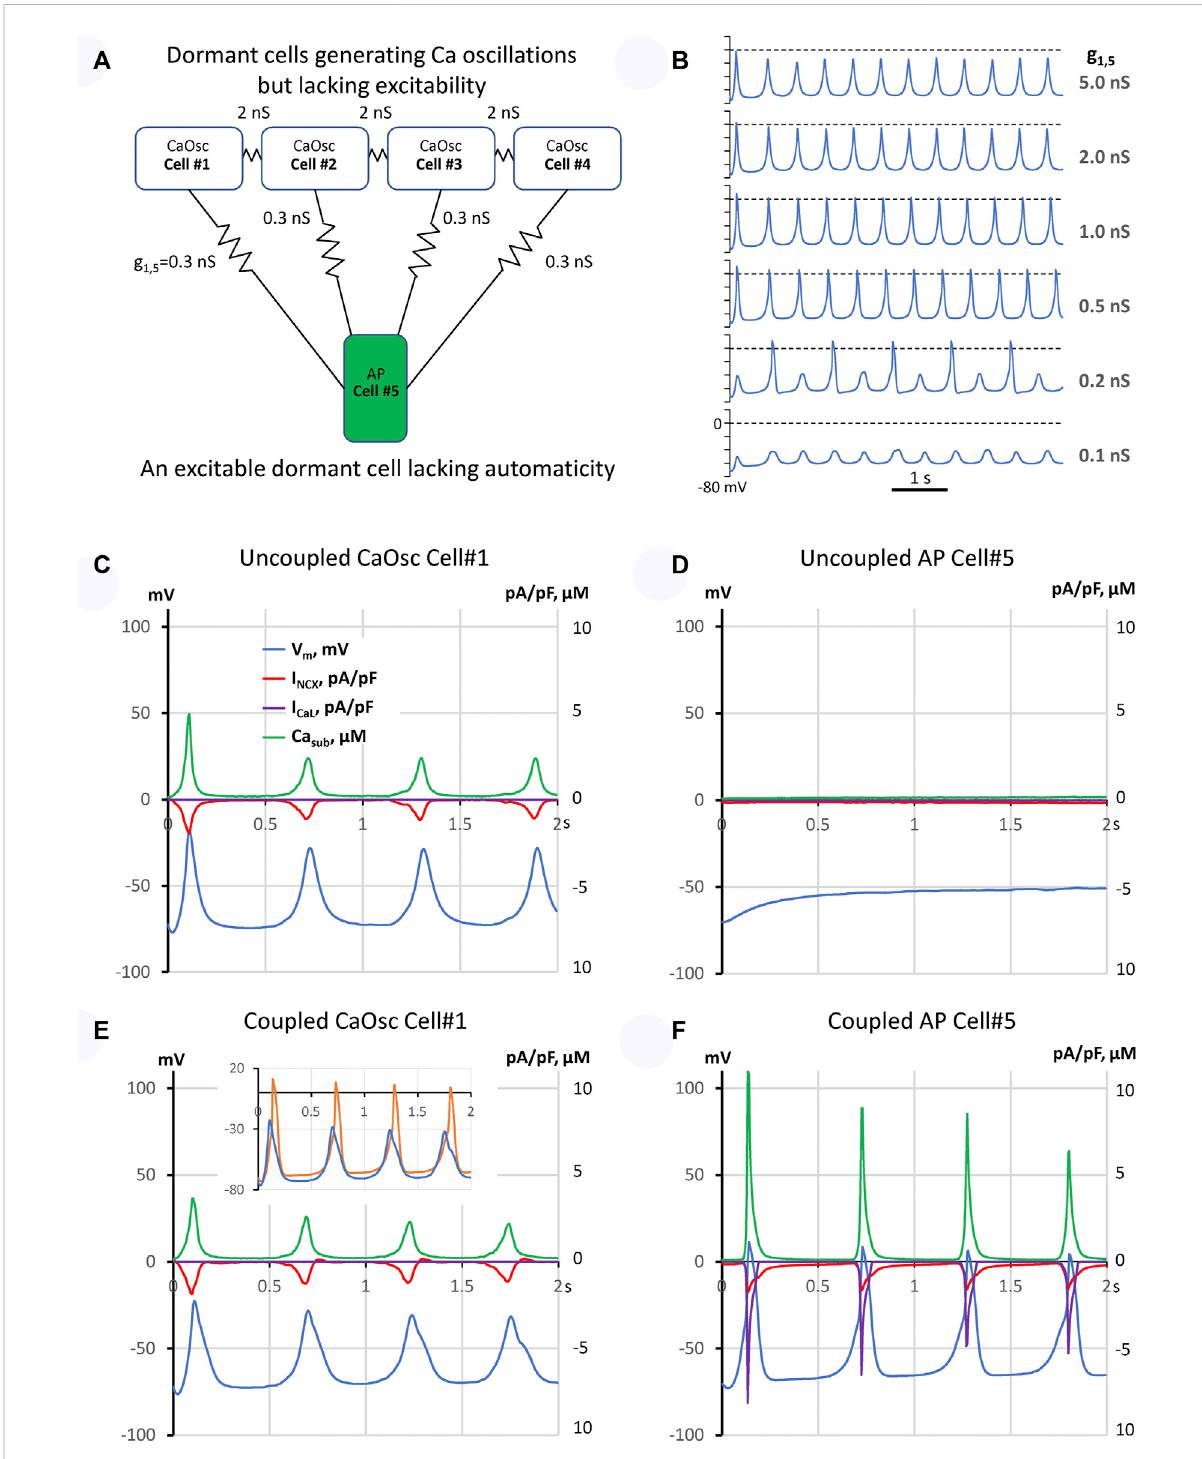
A model of emergent pacemaking in a network of fi ve dormant cells (lacking intrinsic automaticity): (A) A diagram of the network: cells #1 – 4 operating as Ca oscillators (CaOsc) and an excitable Cell #5 (i.e., AP capable cell, labelled as APC) are loosely connected (zigzag lines with conductance values). (B) V m time course of Cell #5 at various coupling with CaOsc cells (g 1,5 ). (C – F) : Time series of I NCX , I CaL , V m , and mean submembrane Ca (Ca sub ) simulated for CaOsc cell #1 and APC cell #5 in separation (C,D) and when cells were coupled (E,F) as shown in panel (A) . Inset in (E) shows overlapped V m in coupled cells #1 (blue) and #5 (orange). V m rise in cell #1 always preceded each AP upstroke in cell #5. See also related Supplementary Video